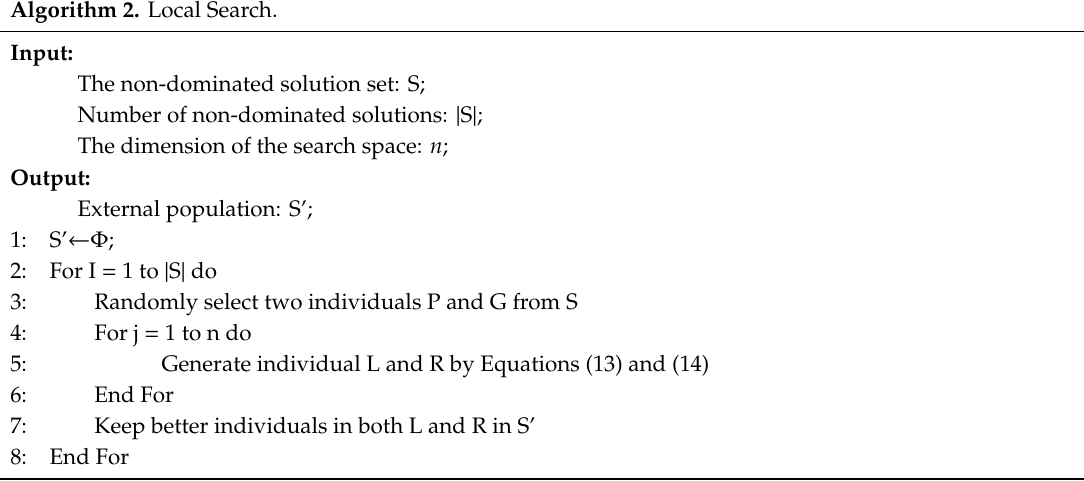
Algorithm 2. Local